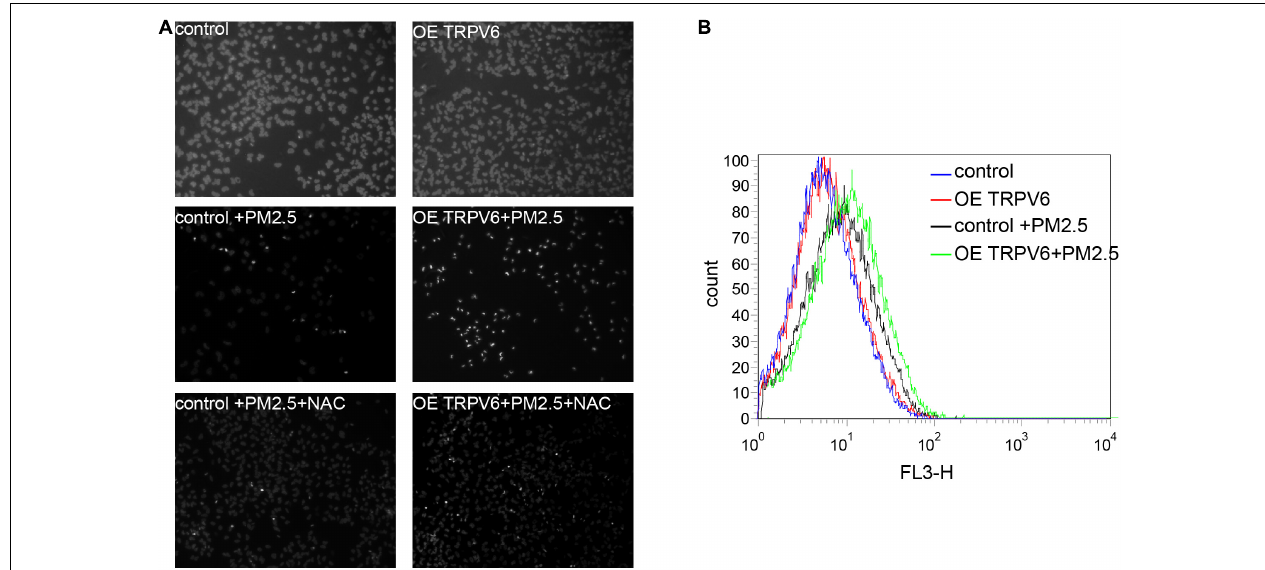
FIGURE 5 | Metal absorption by TRPV6 initiated ROS-mediated PM 2 . 5 -induced apoptosis. (A) Fluorescent images indicate the degree of apoptosis. DAPI was used to stain the nucleus to evaluate apoptosis, nuclear pyknosis (bright, small, irregular) represented apoptosis. Normal L02 cells and TRPV6 overexpressing L02 cells showed good growth (upper panel). PM 2 . 5 -induced apoptosis of L02 cells (middle left, fluorescent represents apoptotic cells), and L02 cells overexpressing TRPV6 showed worse growth (middle right). Addition of NAC suppressed the effect of PM 2 . 5 , and upregulated TRPV6 (lower panel). TRPV6 overexpression increased apoptosis of L02 cells, whereas NAC (ROS inhibitor) decreased apoptosis. (B) Evaluation of ROS production in cells using DCFDA. ROS was evaluated by staining cells with a DCFDA cell reactive oxygen species detection kit. ROS levels were quantified via flow cytometry (BD Biosciences, United States). PM 2 . 5 (black line) induced ROS generation, while TRPV6 overexpression (green line) elevated the effect of PM 2 . 5